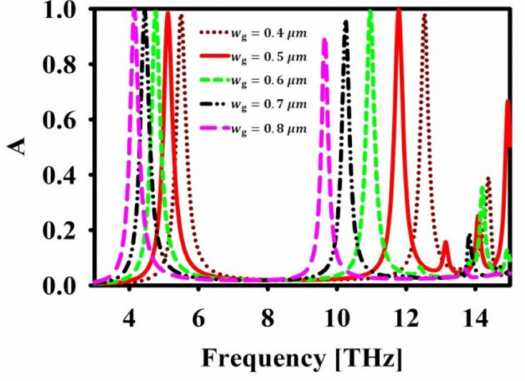
Figure 5. Effect of w g in absorption (A) spectra.